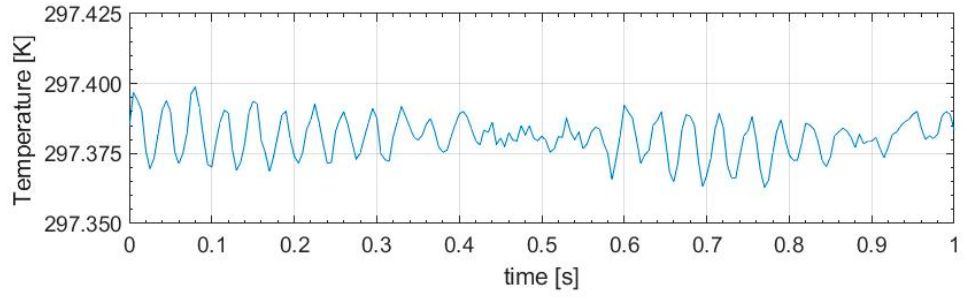
Figure 2. Sampling of a real signal using a cooled IR camera FLIR X6540sc.